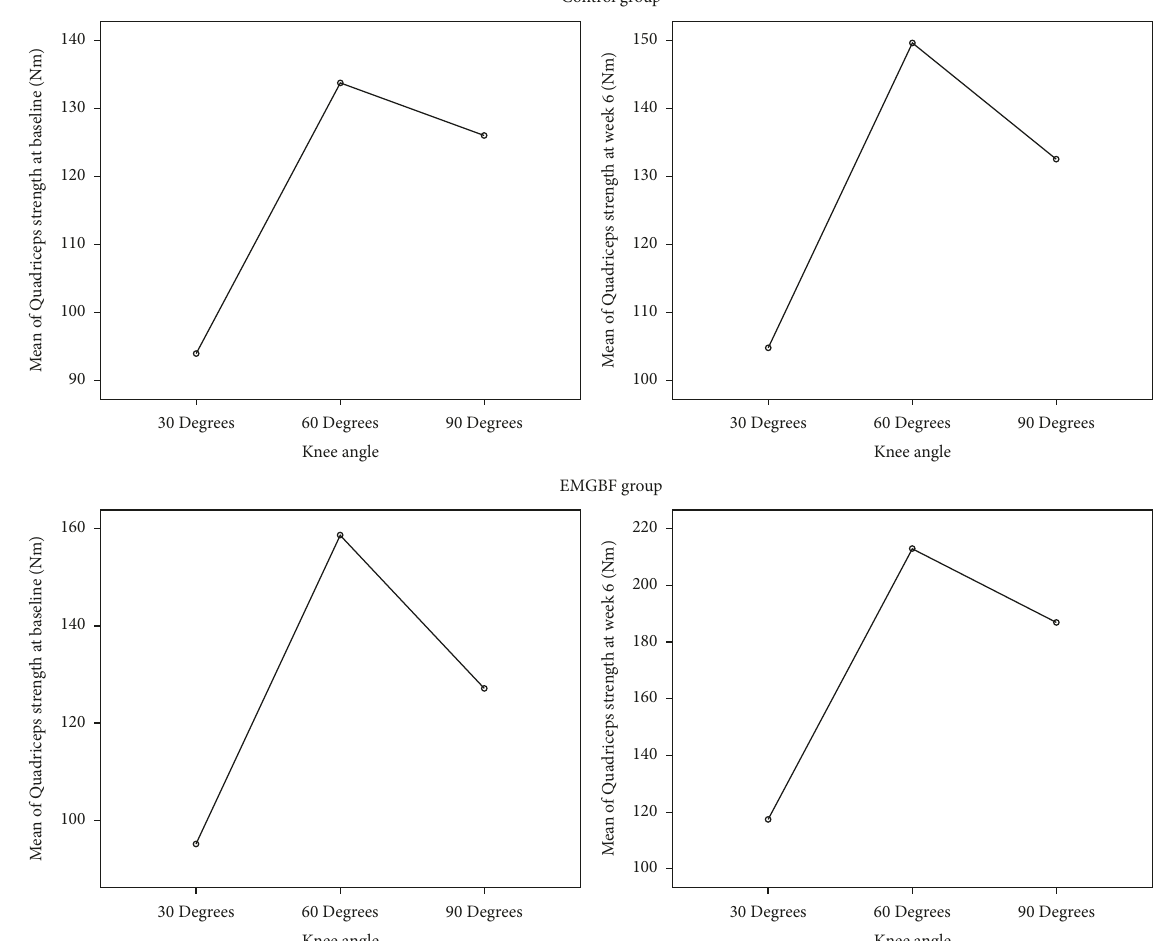
Figure 6: Comparison of quadriceps strength at baseline and after